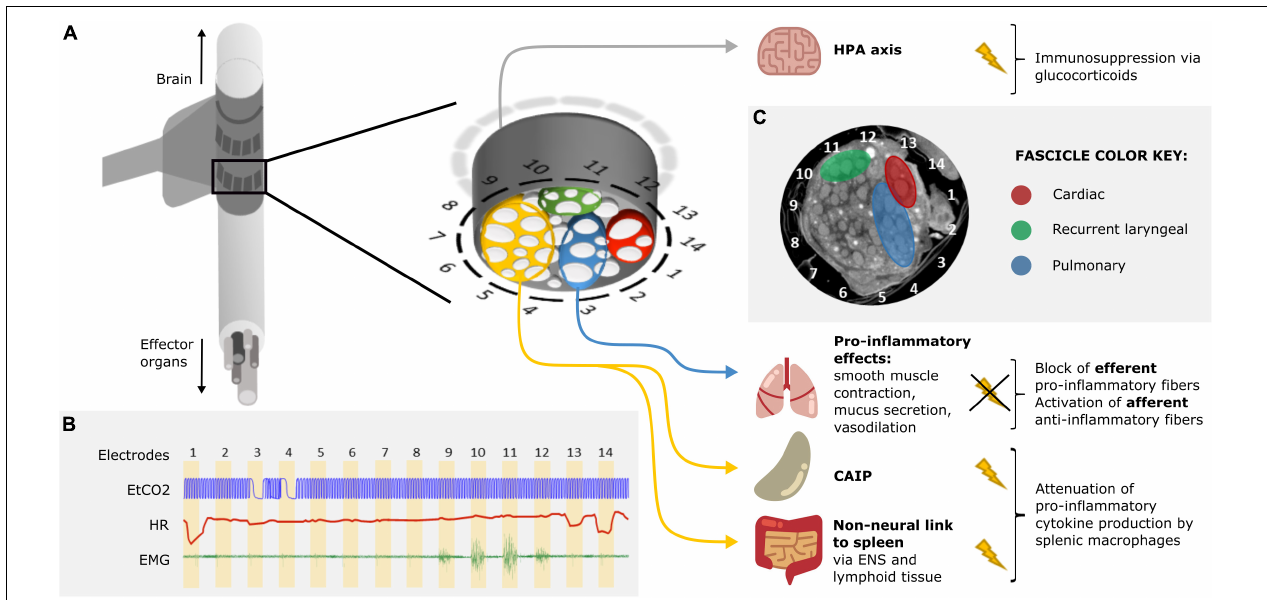
FIGURE 2 | Proposed approach for VNS in ARDS treatment. (A) A schematic of a silicone rubber cuff with 14 circumferential electrodes wrapped around the vagus nerve. Inset: a more detailed schematic of the cross-section of the vagus nerve surrounded by electrodes. The fascicles (white) of the nerve (gray) are grouped into four regions identified by selective stimulation and by subsequent micro-computed tomography (microCT): recurrent laryngeal (green), cardiac (red), pulmonary (blue), and the rest of the nerve with fascicles suspected to innervate the abdominal viscera (orange). Stimulation of the orange region of the nerve would result in the activation of the cholinergic anti-inflammatory pathway (CAIP) and the non-neural link between the vagus and the spleen, via the enteric nervous system (ENS) and lymphoid tissue of the gastrointestinal tract (GIT), via vagal efferents resulting in the attenuation of pro-inflammatory cytokine production. Stimulation of the vagal afferents would activate the hypothalamic-pituitary-adrenal (HPA) axis which would result in immunosuppression via glucocorticoids. Selective blocking of the pulmonary fascicles would prevent activation of pulmonary efferent fibers and the inflammation-potentiating effects of smooth muscle contraction, increased mucus secretion and vasodilation in the lungs. Overall, suppression of the immune reaction would be achieved. (B) Identification of organ-specific fascicles with a quick round of selective VNS. The pulmonary, cardiac, and recurrent laryngeal fascicles are localized by sequential stimulation of the radial sections of the nerve via electrode pairs 1–14 (stimulation for 30 s on each pair followed by 30 s recovery period) and reading out of physiological parameters: changes in respiration (end-tidal CO2, EtCO2), heart rate (HR), and contraction of the neck muscles (electromyography, EMG), accordingly. Pulmonary fascicles are located next to electrode pairs 3 and 4 (bradypnea); cardiac fascicles next to pairs 1, 13, and 14 (bradycardia); and recurrent laryngeal fascicles next to pairs 10 and 11 (maximal EMG signal). (C) A microCT cross-section of a vagus nerve at the cervical level with identified regions containing recurrent laryngeal (green), cardiac (red), and pulmonary (blue) fascicles (unpublished data, study on the left vagus nerve in